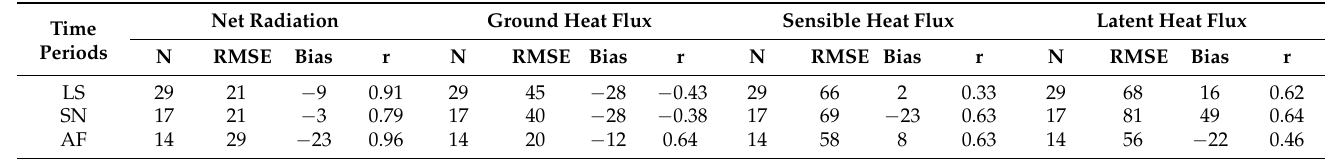
Table A3. The performance of the TSEB-2T model coupled with the Norman and Kustas (NK) resistance model at different research sites with different times shown by different evaluation metrics. “LS” stands for the results that occurred in Landsat time; “SN” near solar noon; and “AF” afternoon. The unit of RMSE and Bias is Wm − 2 .